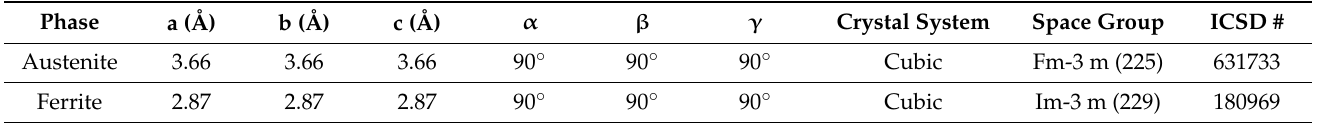
Table 3. Crystallographic information for phases used for EBSD